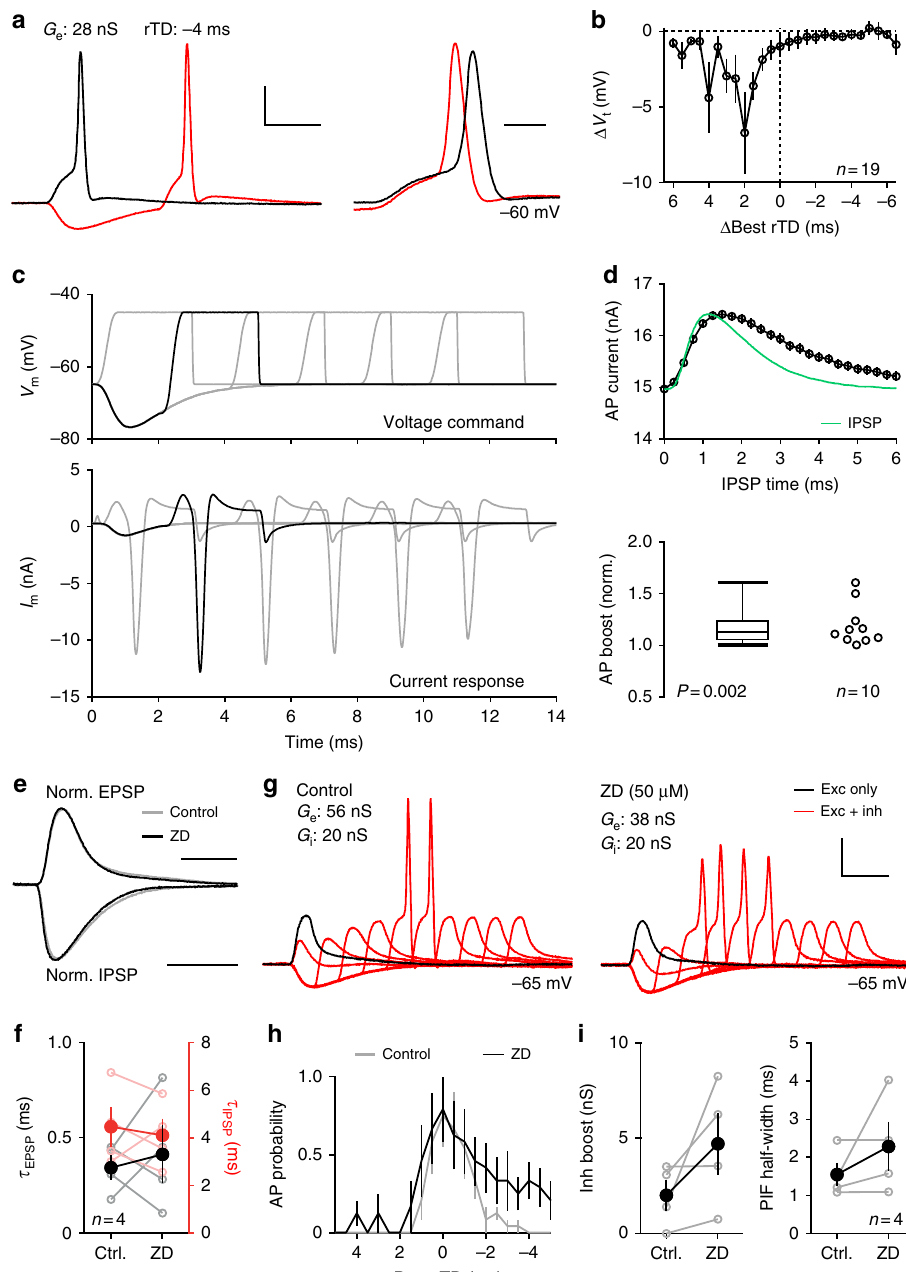
Fig. 5 Changes in membrane excitability and HCN channel activity contribute to PIF in vitro. a Voltage traces from an representative single-event conductance-clamp experiment at a G e value that generated a spike from excitation alone (black). The same protocol performed with an inhibition time at – 4 ms rTD (red) also produced a spike but occurred earlier and with a lower voltage threshold ( V t , right). Scale bars: 20 mV, 2 ms (left) and 0.5 ms (right). b Quanti fi cation of the relative change of spike voltage threshold as a function of Δ Best rTD. c Example traces from a voltage-clamp recording where the voltage command (top) started as an IPSP waveform, but then stepped to a suprathreshold value (3 ms duration) after a particular time (IPSP time). The resulting current response (bottom) shows a transient inward current that re fl ects sodium currents associated with an AP. Traces at an IPSP time of 2.5 ms are highlighted in black. d Top: mean AP current amplitude as a function of IPSP time for the recording in c . Inverted IPSP time course (green) is overlaid to compare with the time course of AP current modulation. Bottom: box plot shows the median and fi rst/third quartiles (whiskers denote the range) of the distribution of AP boost for all recordings (open markers). e , f Example normalized traces ( e ) and quanti fi cation ( f ) of EPSP and IPSP decay kinetics before and after HCN channel blocker (ZD) wash-in. Scale bars ( e ): 2 ms (top) and 5 ms (bottom). g Example traces from a single-event conductance-clamp PIF protocol before (left) and after (right) ZD wash-in. Scale bar: 20 mV, 2 ms. h Average PIF functions for before (gray) and after (dotted black) ZD wash-in. i Population maximum inhibitory boost (left) and PIF function half-width (right) compared between control and after ZD wash-in. Light and bold lines and markers in f , i indicate individual experiments and population averages,